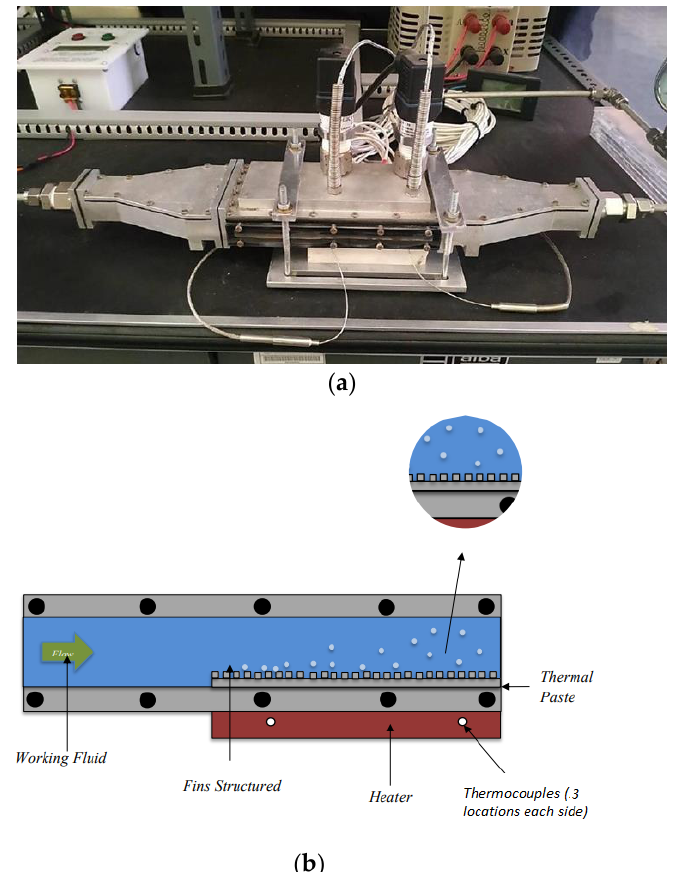
Figure 2. ( a ) Evaporator chamber of the experimental facility and ( b ) schematic diagram and sensors